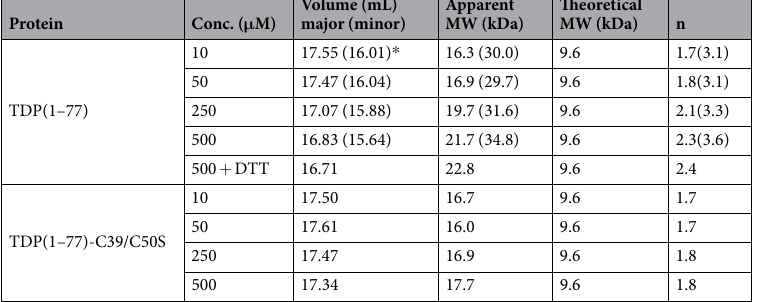
Table 2. Apparent MWs of TDP(1–77) and its Cys mutants at different concentrations as determined by SEC. The Superdex-200 Increase 10/30 GL column was applied to SEC experiments. * Data in parentheses for minor peaks; n, ratio of the apparent MW to theoretical MW; Conc., concentration.